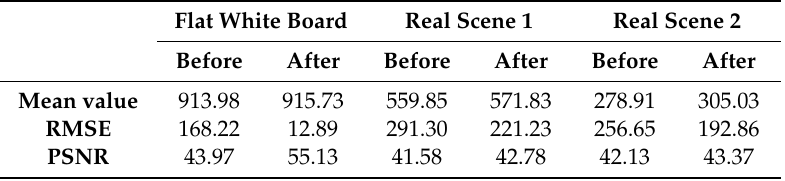
Table 3. Quantitative analysis of the grayscale calibration